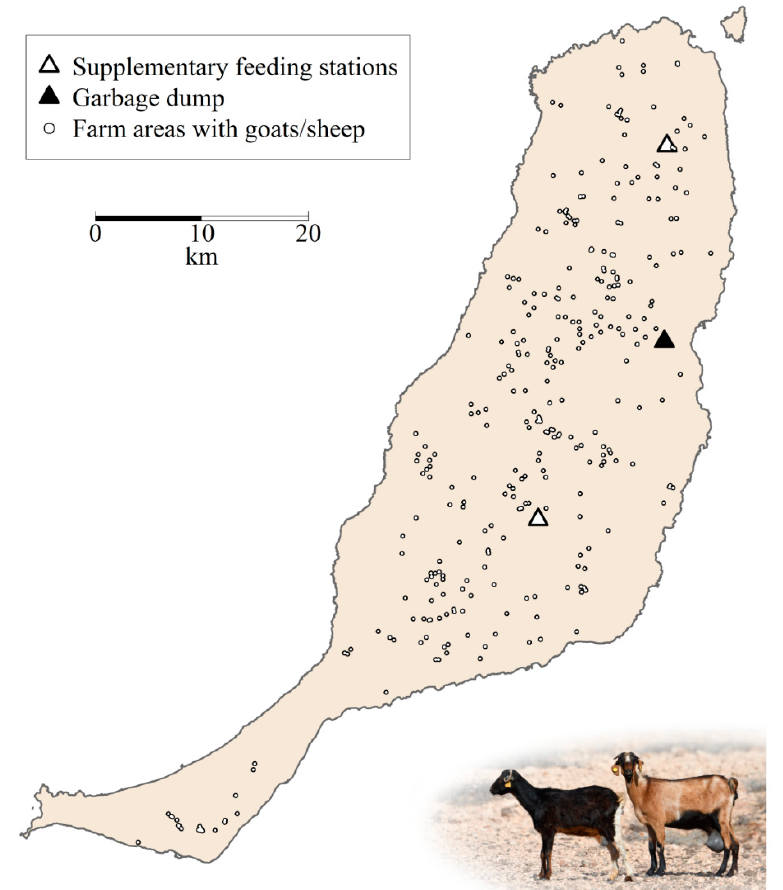
Figure 1. Canarian Egyptian Vulture feeding on a goat carcass in the supplementary feeding station located in the center of Fuerteventura Island. Photography© Manuel de la Riva.